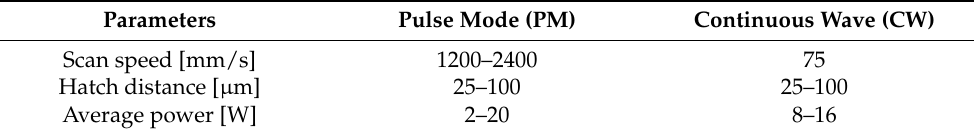
Table 1. Parameters of the laser system used in processing of titanium alloy